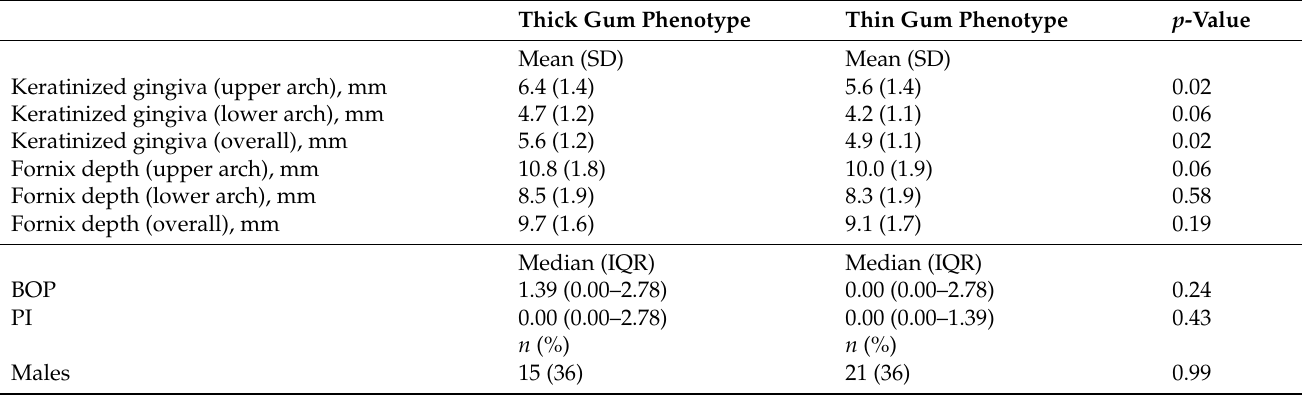
Table 3. Associations between clinically relevant parameters and gum phenotype.